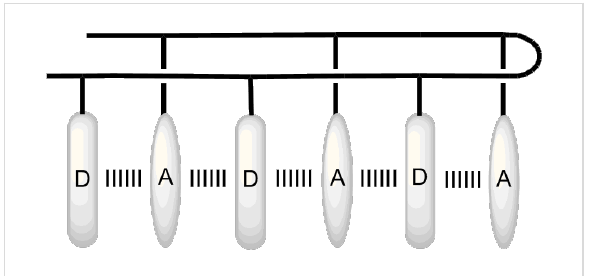
Figure 2: Zipper-featured folding motif of δ -peptides 11a–g driven by the cooperative donor–acceptor interaction [22].